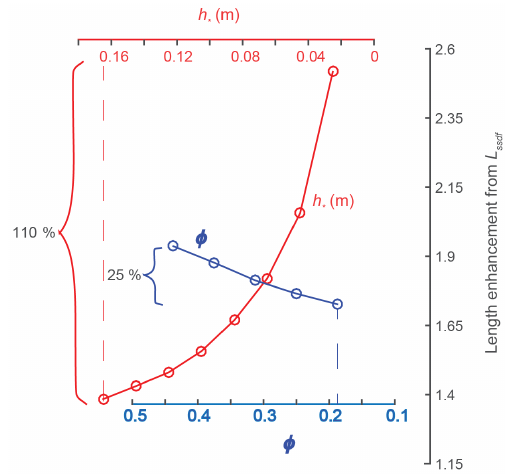
Figure 10. Sensitivity of steady state debris-covered glacier length to choices of characteristic debris thickness ( h ∗ ) and surface debris porosity ( φ ). The lines intersect at the base parameter set. Parameter ranges are extreme to highlight the possible range of effects of each